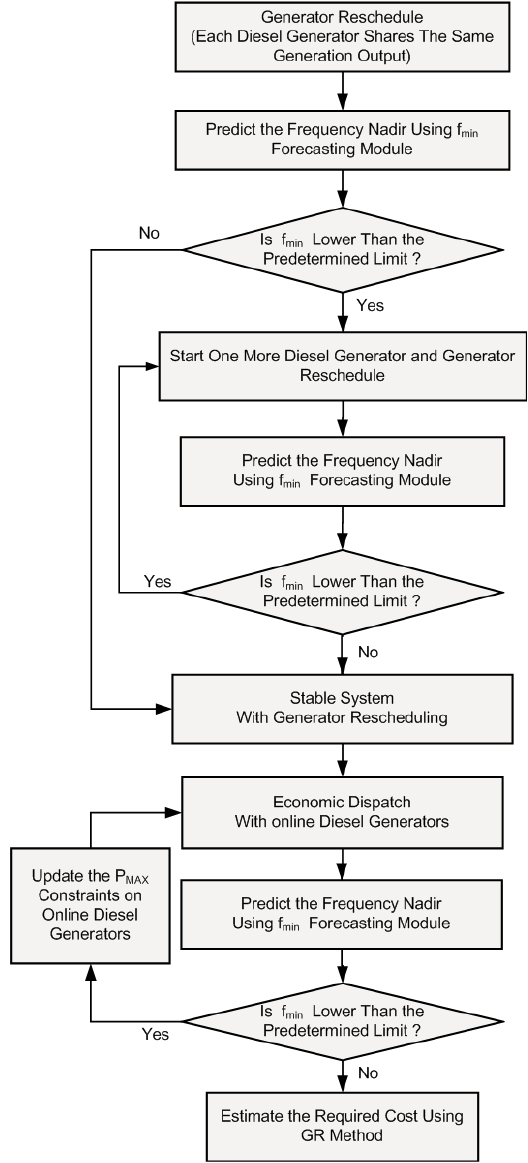
Figure 2. The operation of the GR method.